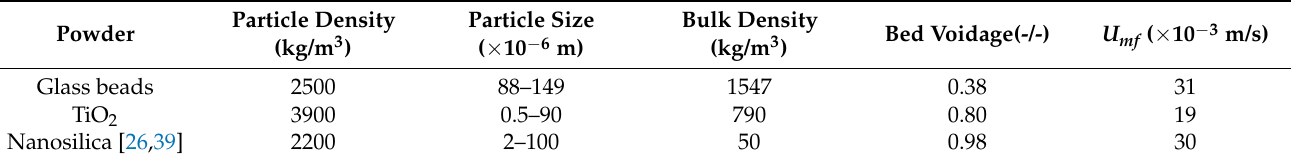
Table 1. Physical properties of solid particles used in the